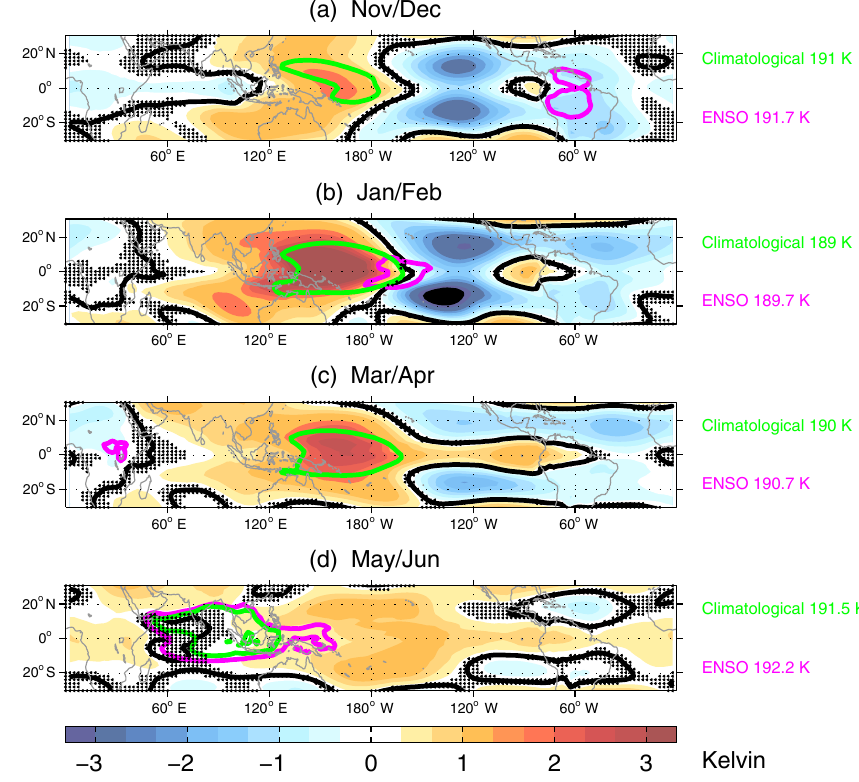
Figure 6. Temperature anomalies (Kelvin) at 100hPa for 1997/1998 in the GEOSCCM AGCM integrations in November–December (a) through the following May–June (d) . Anomalies that are not significant at the 95% level are marked by black symbols. The green and magenta contours denote specific cold isotherms in the climatology and for this specific composite in order to highlight the location of the cold point. The effect of the QBO at 50hPa and the linear trend have been linearly regressed out of all anomalies before ENSO composites are formed (see Sect. 3). The contour interval is 1 /